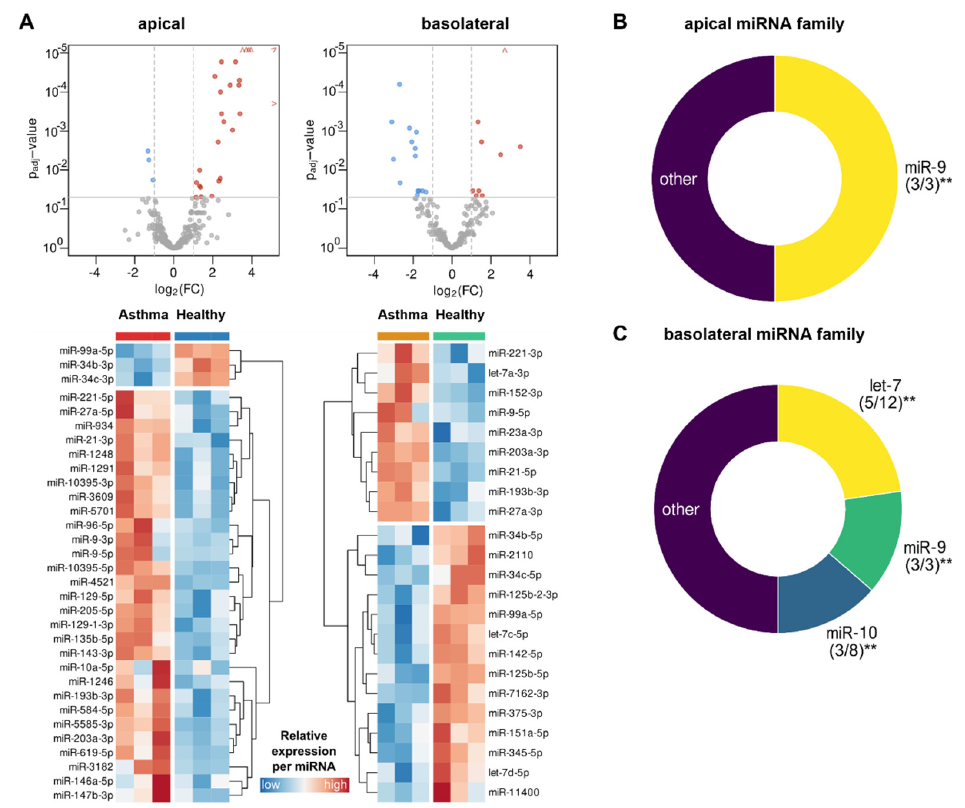
Figure 7. Differential miRNA expression analysis per disease condition (asthma versus healthy) and compartment (apical and basolateral). ( A ) Volcano plot and heat map of differentially expressed miRNAs of asthma versus healthy comparison in EVs from the apical (left) and basolateral (right) cell culture compartments at p adj < 0.05 and FC ≥ 2, and ( B , C ) donut charts showing the distribution